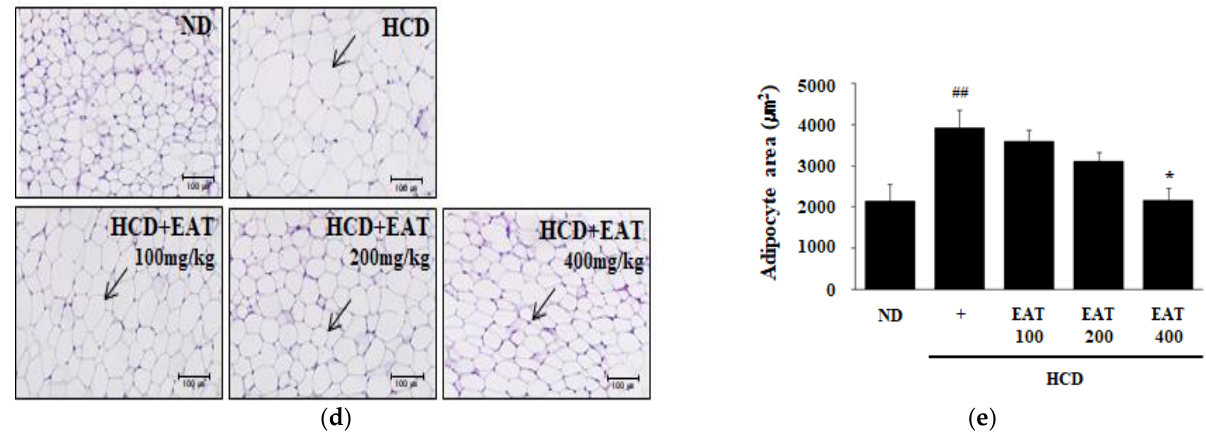
Figure 2. Effect of EAT on the white adipose tissue (WAT) weight and histological analysis in an HCD-induced C57BL/6 mouse model. ( a – c ) To assess the change in body weight induced by HCD, WAT was collected and the weight for each area including ( a ) epididymal, ( b ) subcutaneous, and ( c ) peritoneal fat was immediately measured at the end of the ex- periment. ( d , e ) For histological analysis of WAT to analyze adipocyte size, WAT was collected and fixed in 10% neutral buffered formalin. The embedded paraffin blocks were cut into 5 μm sections and stained with hematoxylin and eosin (H&E). ( d ) The change in size of adipocytes was observed under a light microscope at 100× magnification and ( e ) the quantification of adipocyte area was measured by ImageJ software. Values are expressed as mean ± SD; ## p < 0.01 com- pared with the ND group; * p < 0.05 compared with the HCD group.